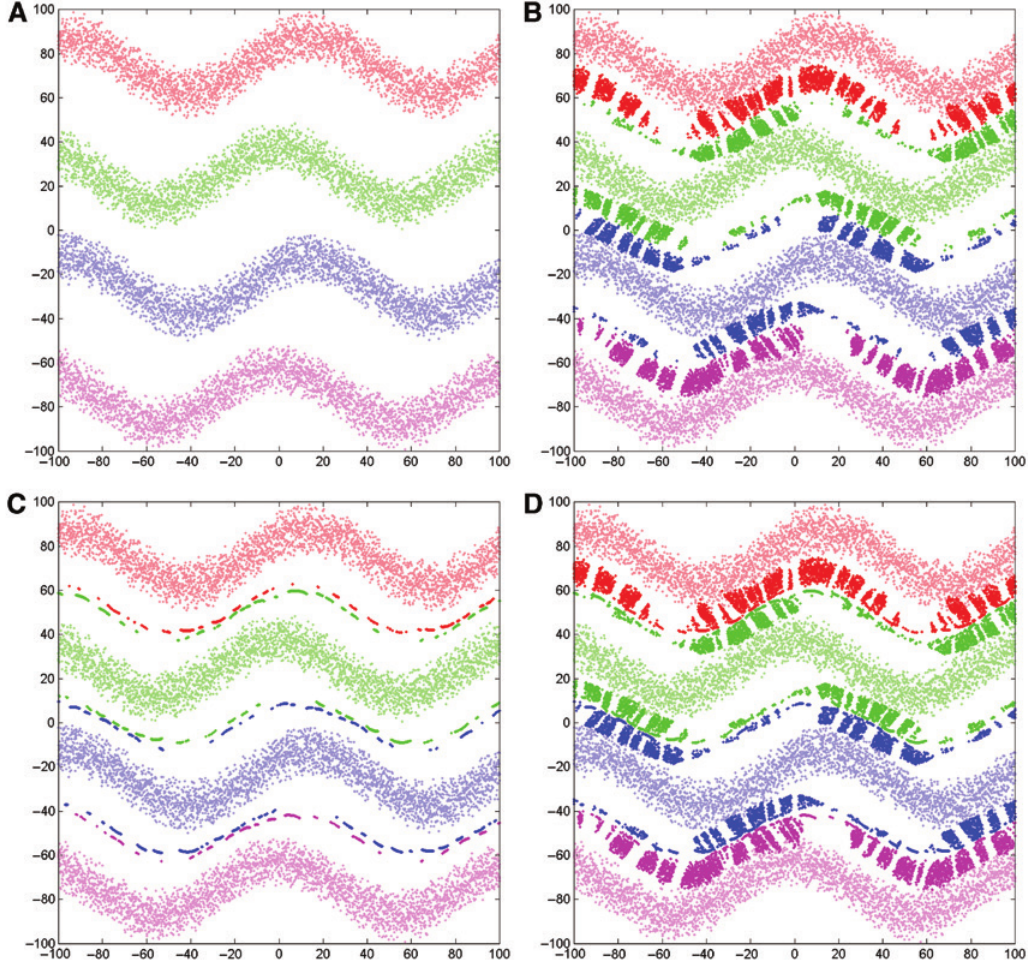
Figure 3: A comparison among various final training sets: (A) An original data set. (B) An original data set with synthesized FMCOVs. (C) An original data set with synthesized AMCOVs. (D) An original data set with synthesized FMCOVs and AMCOVs